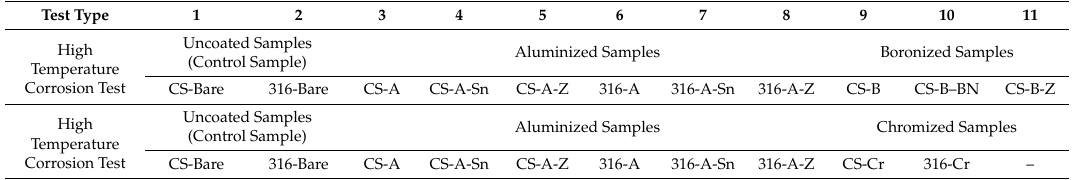
Table 2. List of the samples exposed to low-temperature and high-temperature corrosive